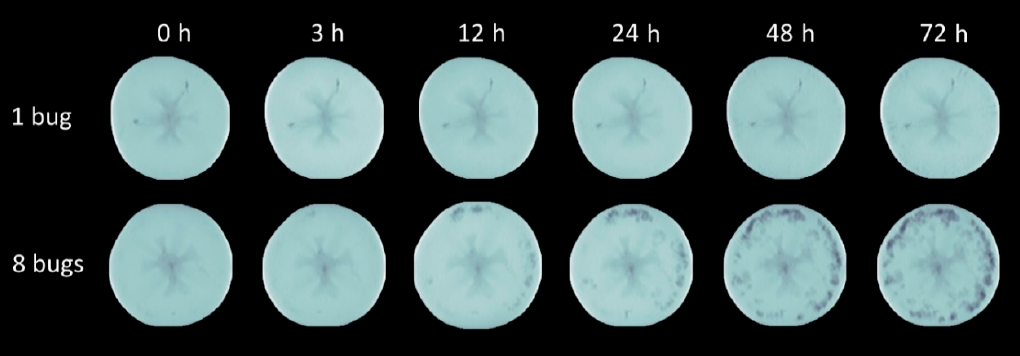
Figure 3. Intensity normalized axial projection.